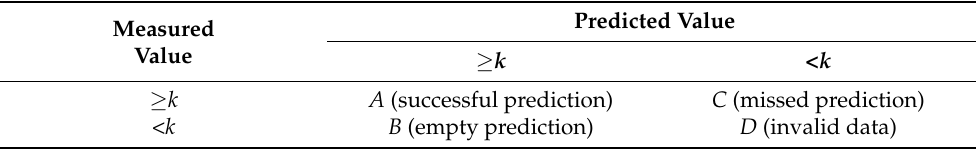
Table 3. Test index classification table of rainfall